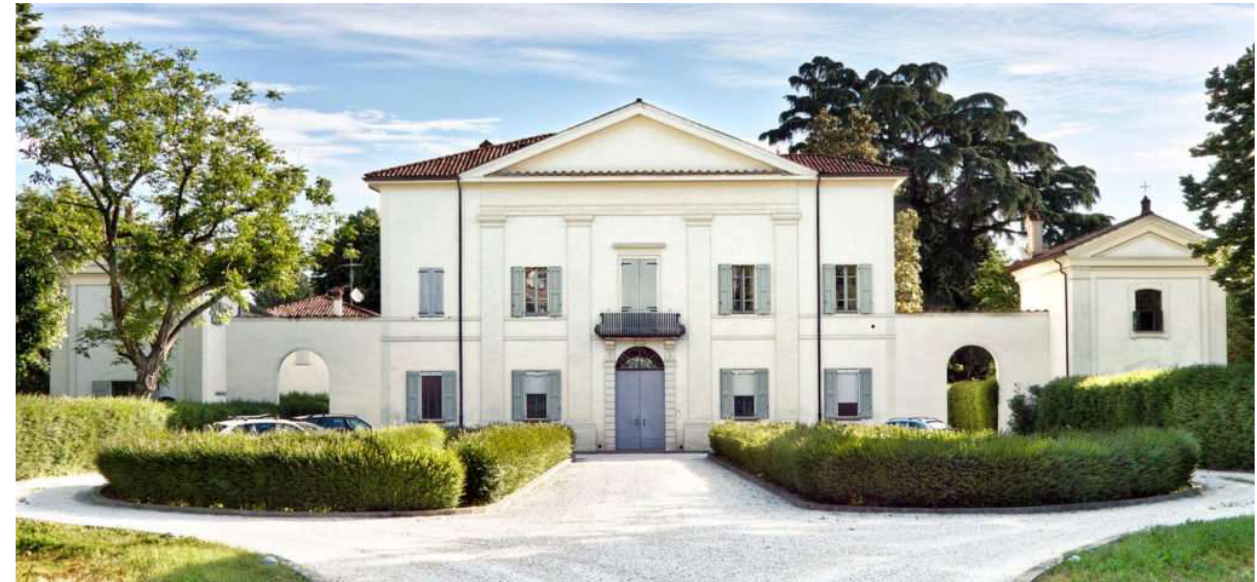
Figure 1. Villa Rivalta today. On the left, covered by trees, is Rota’s ancient annex building that is decorated with a pictorial cycle illustrating medical scenes.